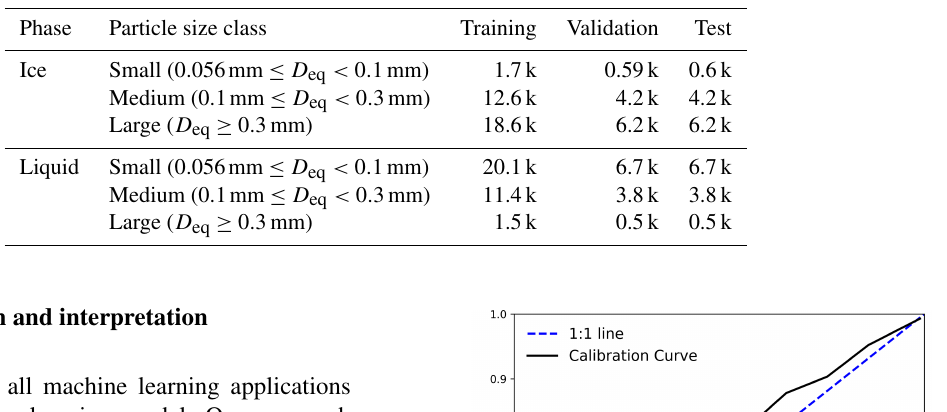
Table 2. Number of particles by size class in the training, validation, and test sets.